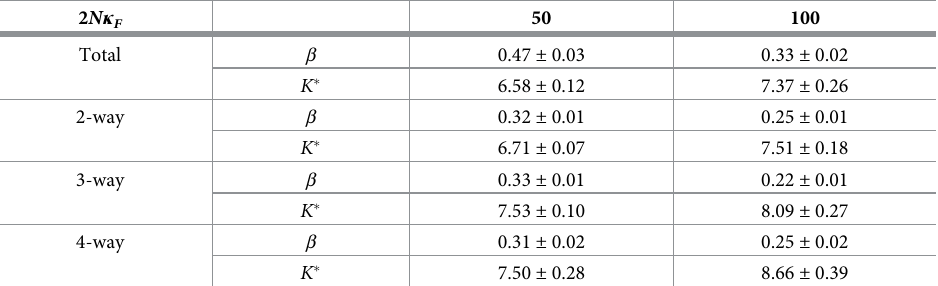
Table 2. Table of values of the parameters characterising the sub-diffusive growth of DMIs for large scaled popula- tion sizes; β = 1 corresponds to normal diffusive motion, β < 1 to sub-diffusion and β > 1 super-diffusion, while K � corresponds roughly to the number of substitutions required to reach the inviable